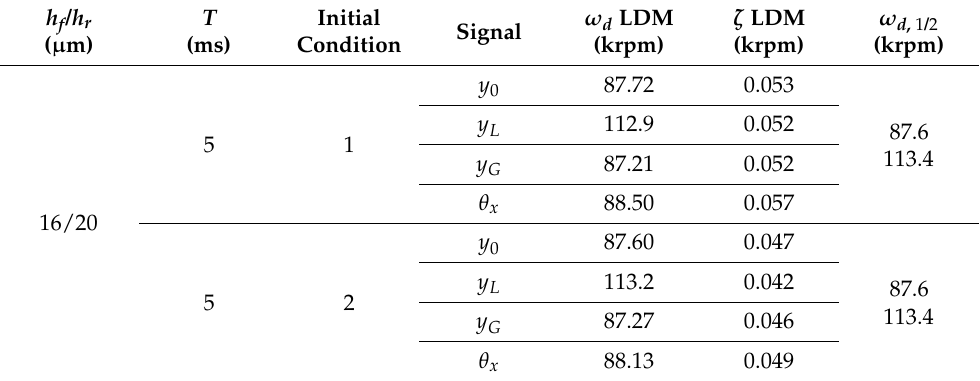
Table A3. Damped frequencies and damping factors resulting from FFT analysis and from LDM; p s = 0.7